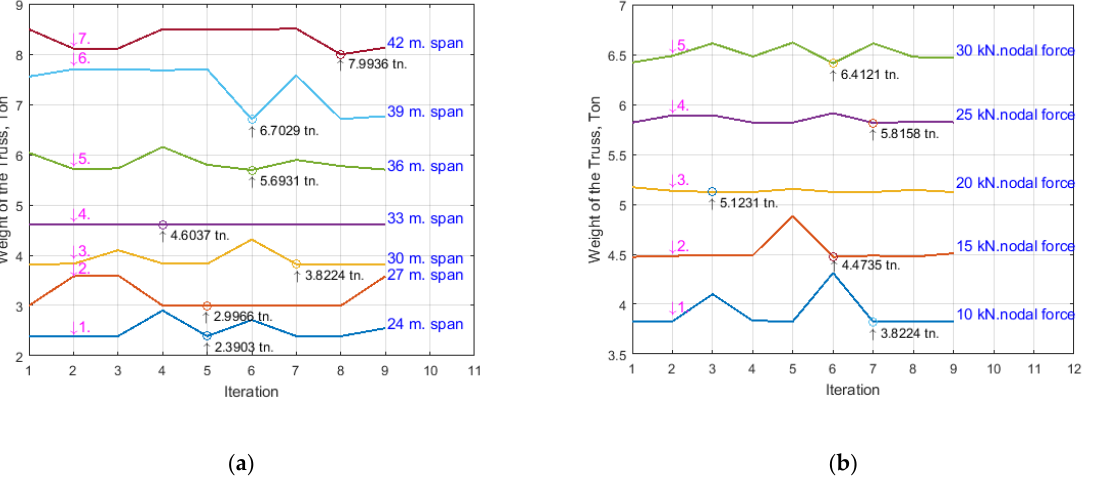
Figure 8. Optimization of the weight of the prestressed arched truss. ( a ) Optimization of the weight (in tons) of the prestressed arched truss at different spans; ( b ) Optimization of the weight (in tons) of the prestressed arched truss at different nodal forces.